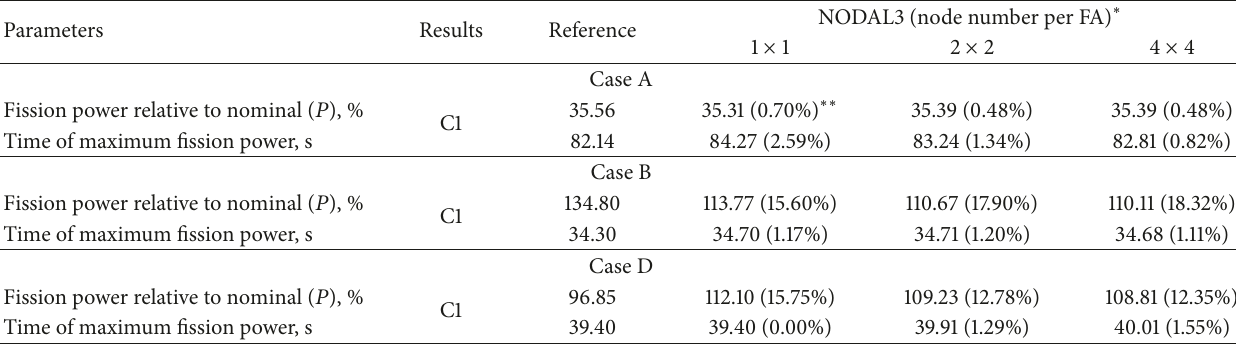
Table 5: Effect of radial node number per FA for fission power and time of peak fission power in Cases A, B, and